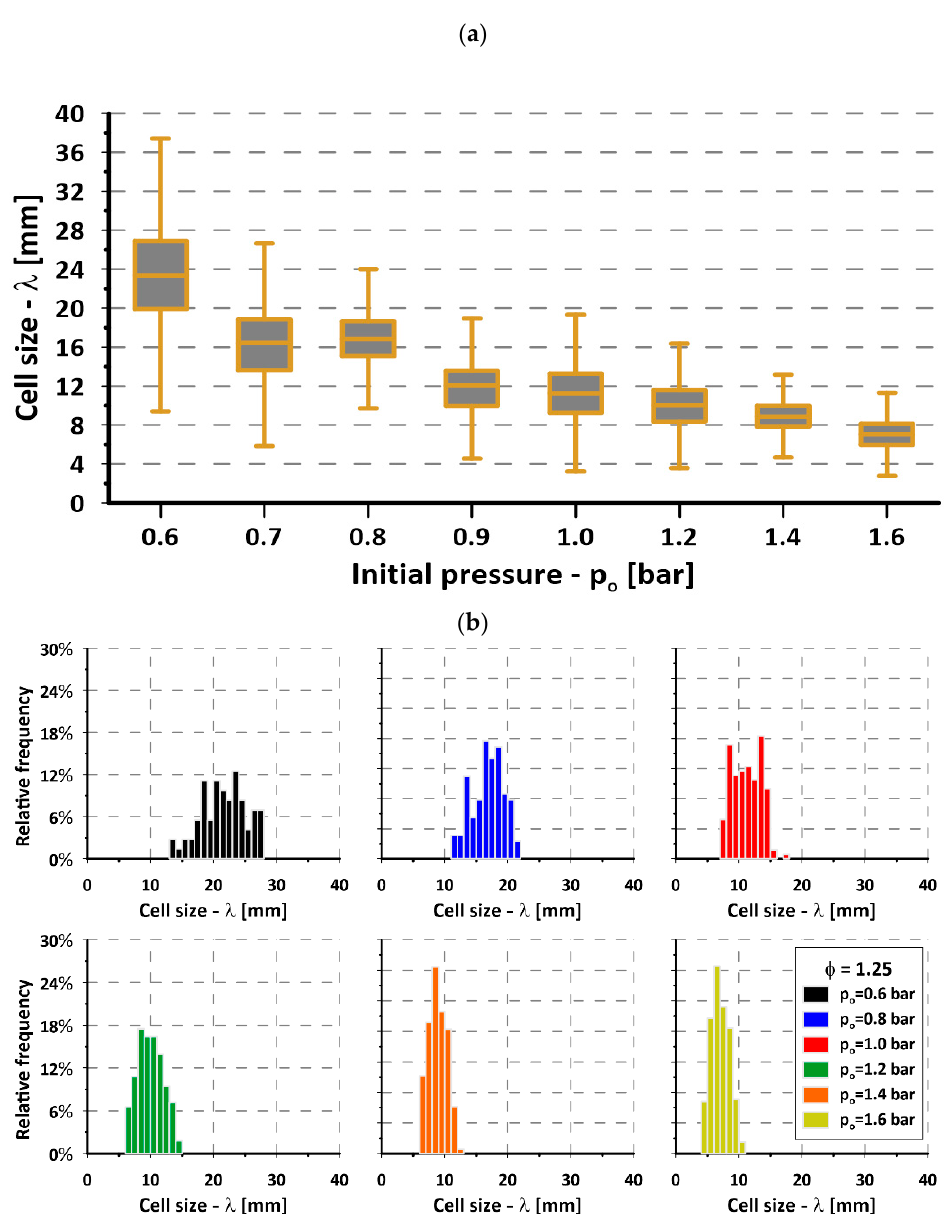
Figure 6. Experimental results for a case of equivalence ratio Φ = 1.25. ( a ) box plots showing the IQR, min, max and mean for each initial pressure; ( b ) histogram showing the data distribution. Table 4. Statistical description of the equivalence ratio Φ = 1.25 case presented in Figure 6.